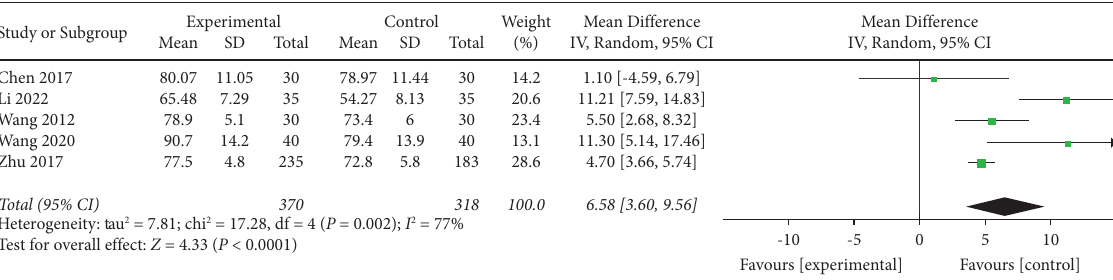
Figure 9: Comparison of the HHS between the AA group and the control